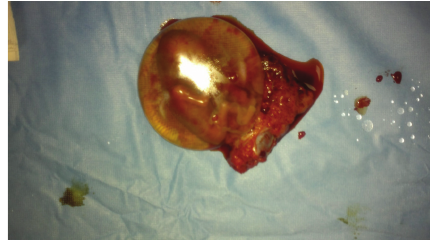
Figure 2: Conceptus adherent to